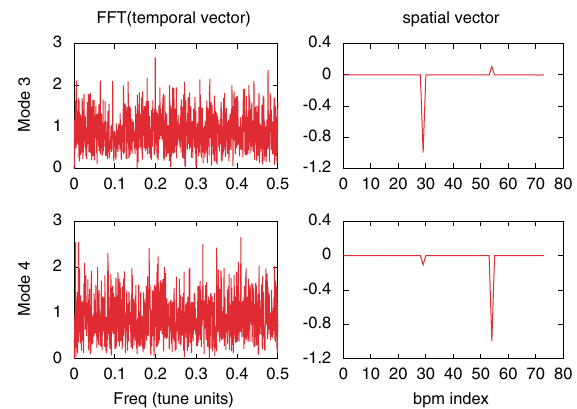
FIG. 3. (Color) Spatial and temporal vectors of modes corre- sponding to two noisy BPMs with